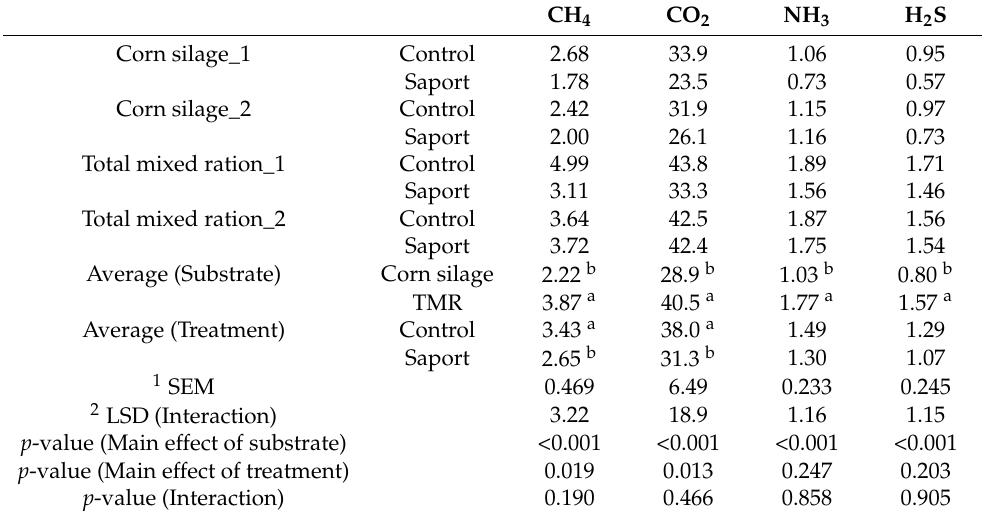
Table 3. Effects of treatments on in vitro methane (CH 4 , mg/g DM), CO 2 (mg/g DM), ammonia (NH 3 , mmol/g DM), and hydrogen sulfide (H 2 S, mmol/g substrate DM) of four dairy diets.